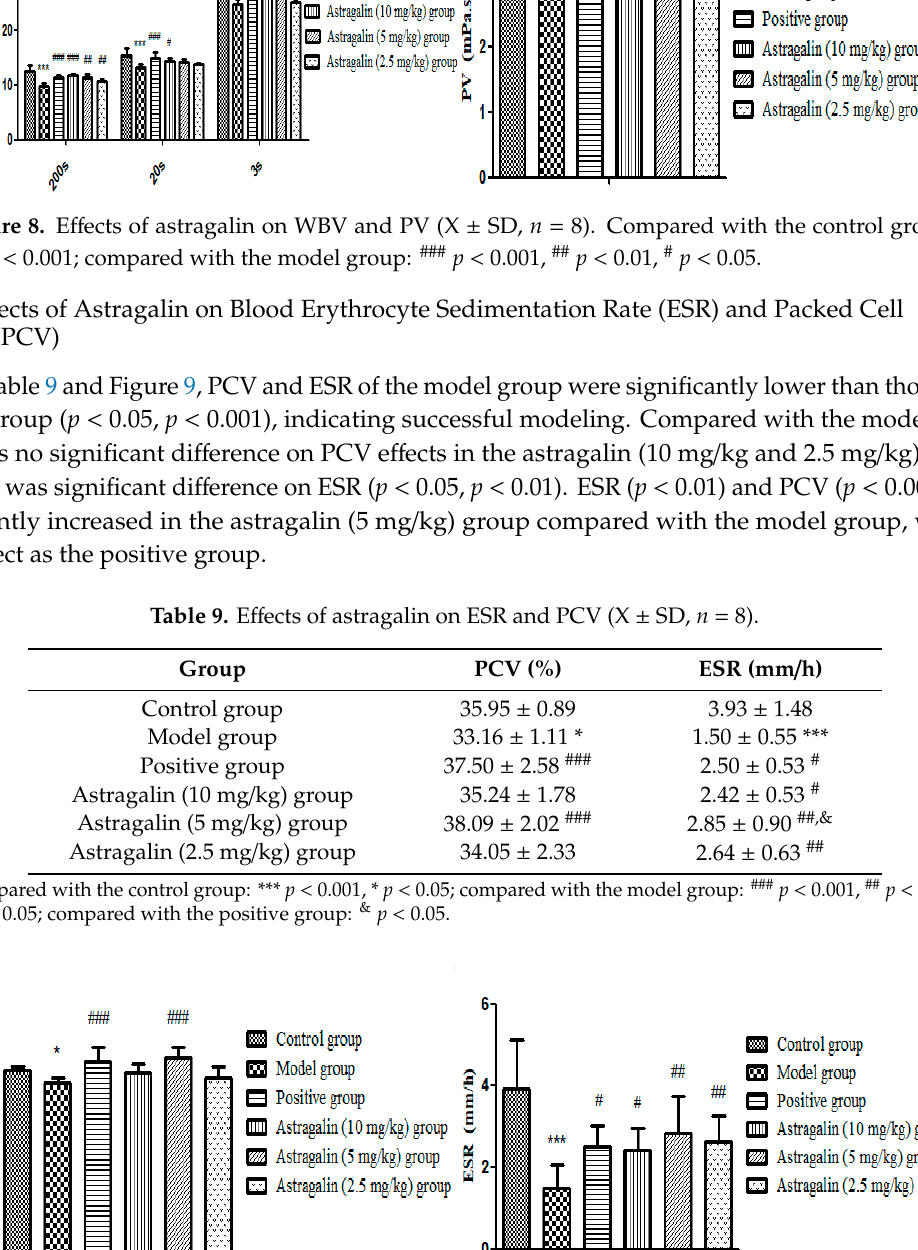
Molecules 2019 , 24 , x 8 of 16 Table 8. Effects of astragalin on WBV and PV (X ± SD, n = 8). Group